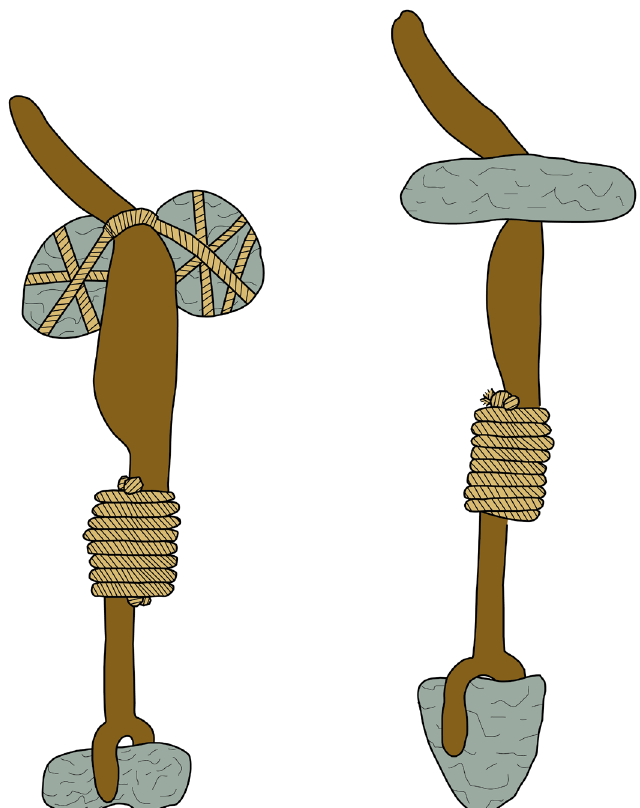
Figure 6. The crank (twist-and-reverse-twist, Stocks 2003: 137) drill and its